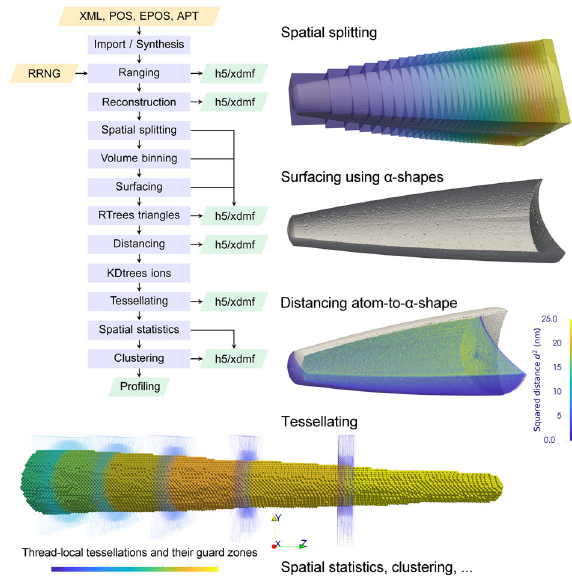
Fig. 3 Paraprobe delivers a collection of tools for implementing high-throughput work fl ows for automated post-processing of single or collections of APT datasets. Each tool serves a speci fi c analysis task. Examples of tools and key processing steps are shown to the right. All results and metadata are exchanged via HDF5 fi les. A typical work fl ow has three steps: First, the desired work fl ow (of analysis tasks) is described via writing a Python script using the paraprobe-parmsetup classes. The script creates the necessary con fi guration fi les and a shell script for executing the work fl ow. Second, the analysis tasks are executed by individual paraprobe tools using a workstation or computer cluster. The fl owchart to the left shows a typical combination of such analysis tasks. Third, the results are post-processed through executing a Python script using the paraprobe-autoreporter classes. These classes parse the meta- data and results from their respective HDF5 fi les and create the desired fi gures alongside a PDF report. The images on the right side detail the functioning of the data splitting and show a slice of an α - shape with which the dataset edge is triangulated. The bottom image shows a tessellated dataset. Here, also the guard zones are visualized (light-blue wireframes). The guard zones are used to ensure a consistent computing of Voronoi cells at the boundary of each dataset